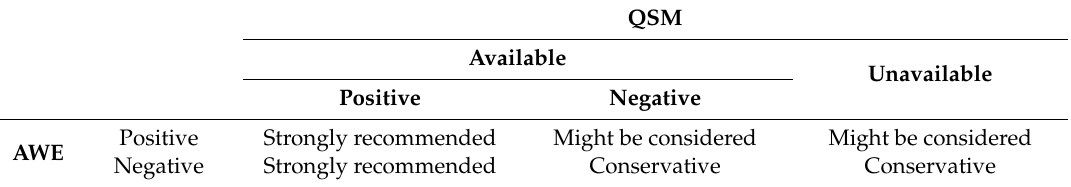
Table 4. Recommendation of surgical treatment for intracranial aneurysm with sentinel headache. QSM Available Unavailable Positive Negative Positive Strongly recommended Might be considered Might be considered AWE Negative Strongly recommended Conservative